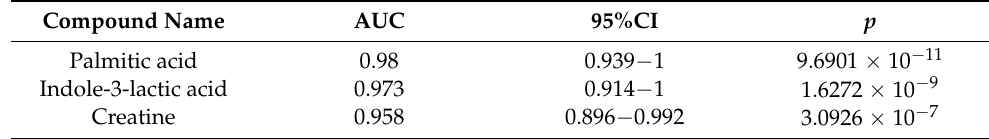
Figure 6. Screening of classification model in brainstem tissue samples from the EFI group relative to the NDRDs group. ( A ) ( a ) Upset plots obtained with biomarker meta-analysis of EFI and four NDRD groups (total of 5 groups, n animal = 10, respectively), with 46 common differential metabolites. ( b – d ) The classification model consisted of three candidate differentials: palmitic acid, creatine, and indole-3-lactic acid; indole-3-lactic was up-regulated in the EFI group, and palmitic acid and creatine were down-regulated. ( B ) Discriminatory ability evaluation of the EFI classification model relative to the NDRDs groups: ( a ) ROC plot: AUC = 0.996 (95% CI: 0.956 − 1); ( b ) the confusion matrix plot showed that one case was wrongly diagnosed as EFI. ( c ) 100 permutation-test plot, p < 0.01. Table 4. The diagnostic efficacy of various metabolites in brainstem tissue samples.